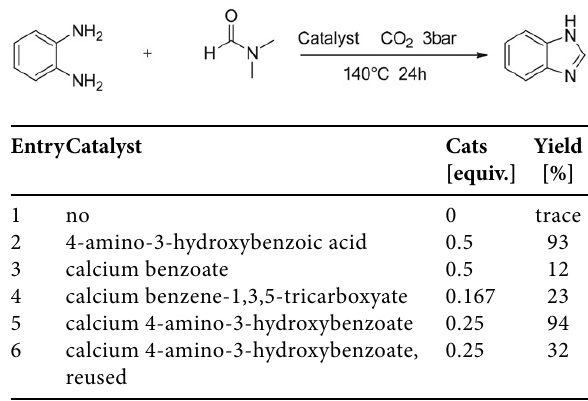
Table 4. The cyclization of o -phenylenediamine and DMF catalyzed by the calcium salts in the presence of CO 2